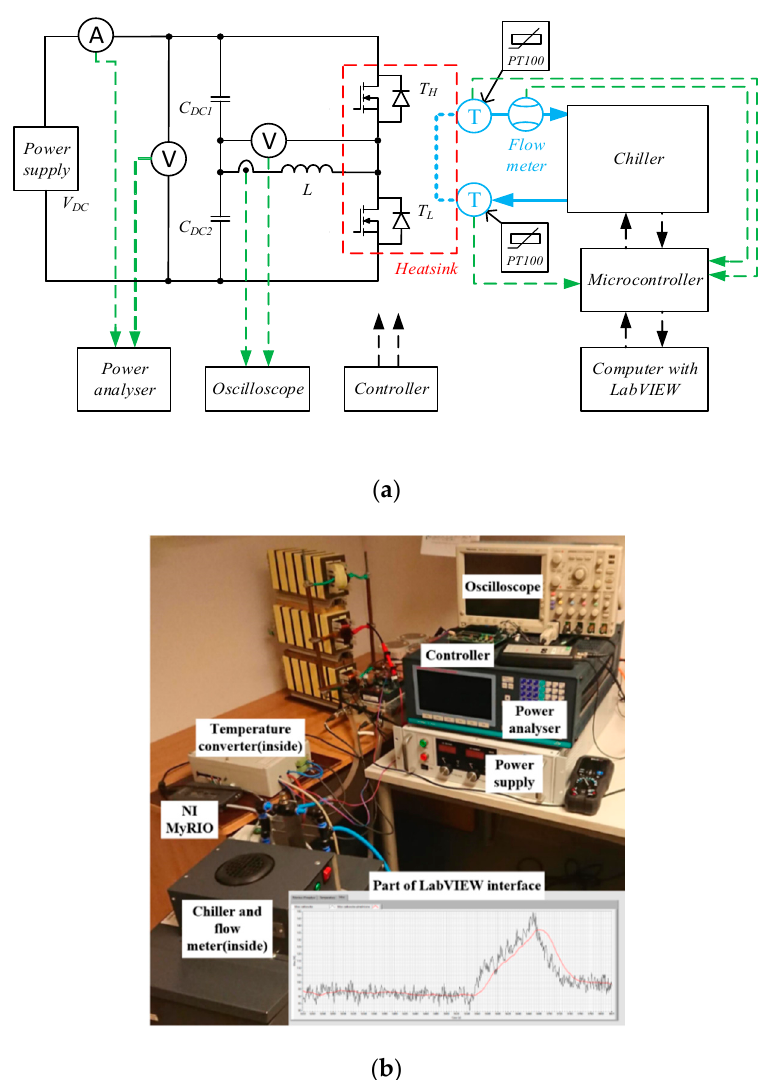
Figure 7. Scheme ( a ) and photo ( b ) of the half-bridge measurement setup.